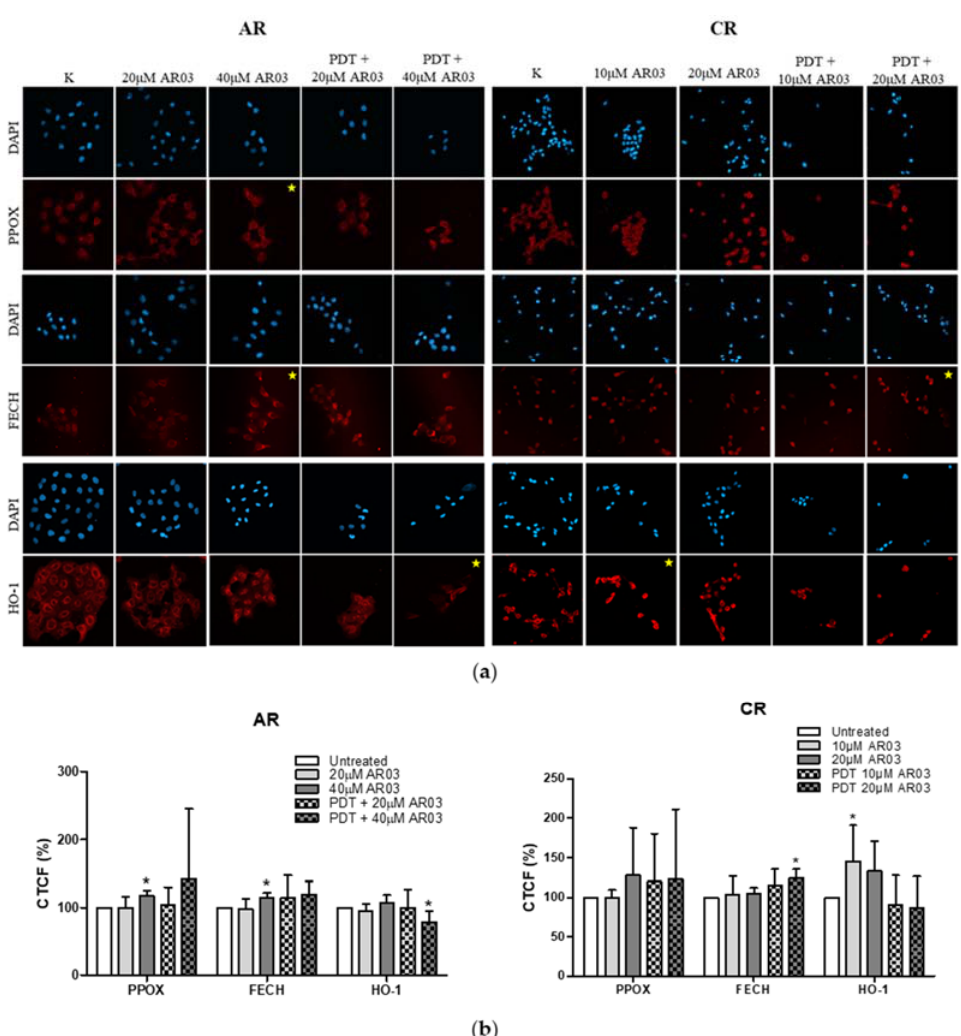
Figure 9. Effect of AR03 on PPOX, FECH, and HO-1 levels. ( a ) Images of stained cells before treatment, after AR03 treatment, or after PDT combined with AR03 treatment. ( b ) Graphs with percentage values CTCF of untreated cells, resistant to PDT. Asterisks indicate the statistical significance of the differences between cells after treatment and untreated control calculated by the Mann–Whitney test (* p ≤ 0.05).